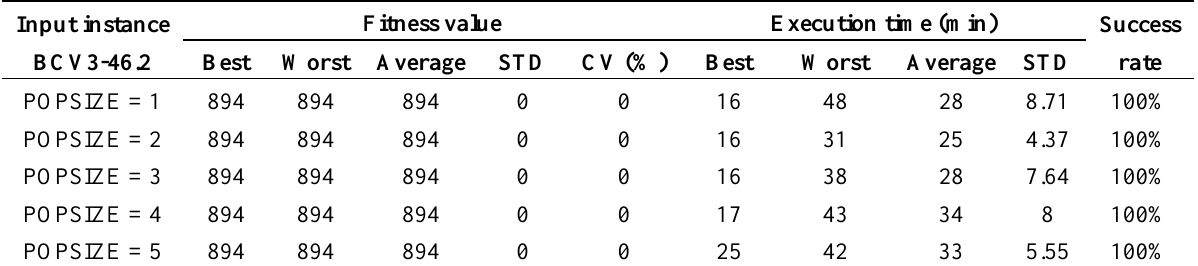
Table 9. Investigating the effect of population size for input instance, BCV3-46.2.